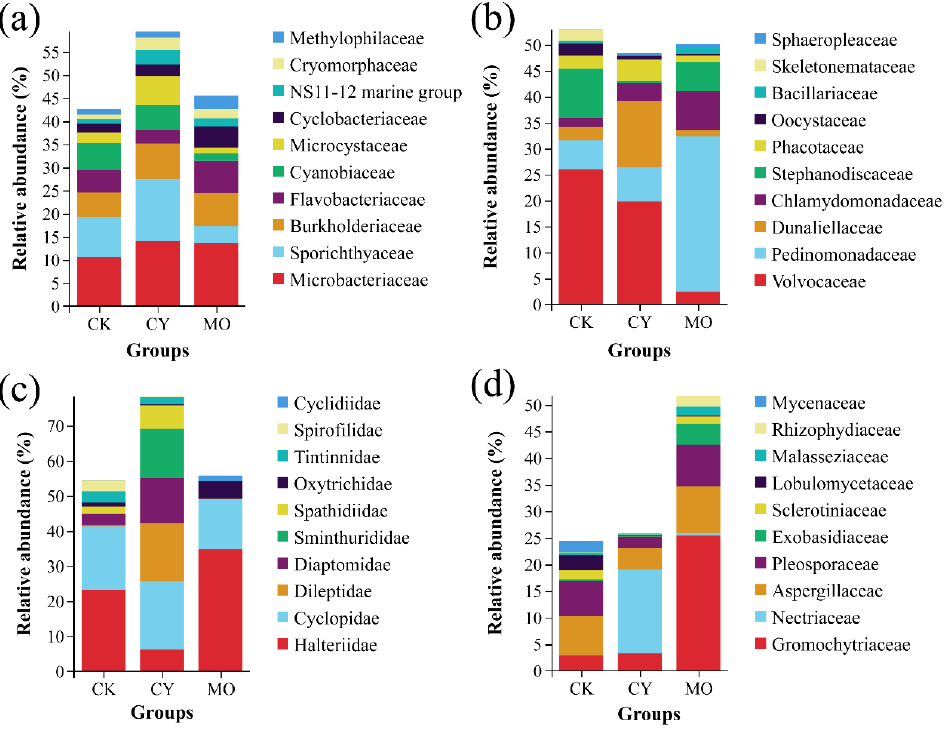
Figure 1. Relative abundance of top 10 dominant ( a ) bacterial, ( b ) phytoplankton, ( c ) zooplankton, and ( d ) fungal families in each group.